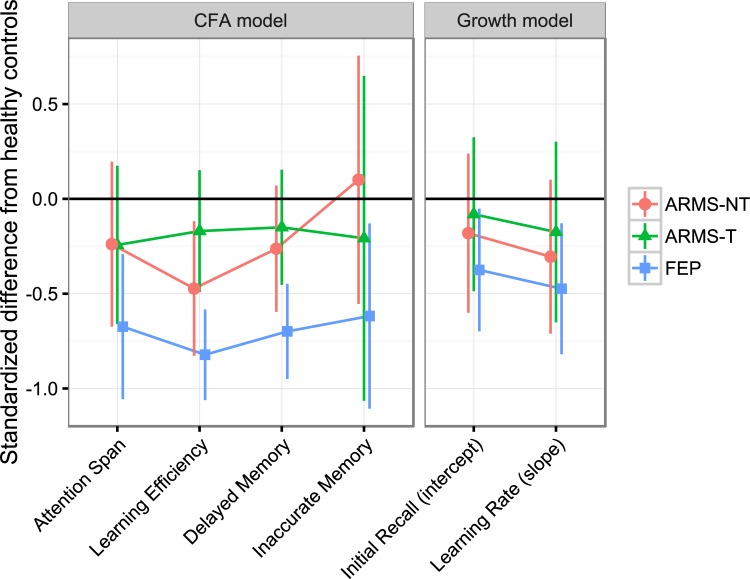
Performances of at-risk mental state (ARMS) patients with (ARMS-T) and without later transition to psychosis (ARMS-NT) and first episode psychosis (FEP) patients on the four factors of the California Verbal Learning Test (CVLT).The horizontal line at zero represents the performance of healthy controls. Differences are expressed in units of standardized mean differences. Differences are significant if the 95% confidence interval does not overlap with the horizontal line. The variable Inaccurate Memory was reversed such that high scores represent a good performance. Differences are adjusted for the influence of sex.